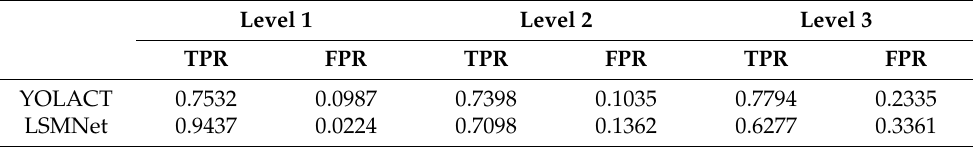
Table 4. OCIS results on